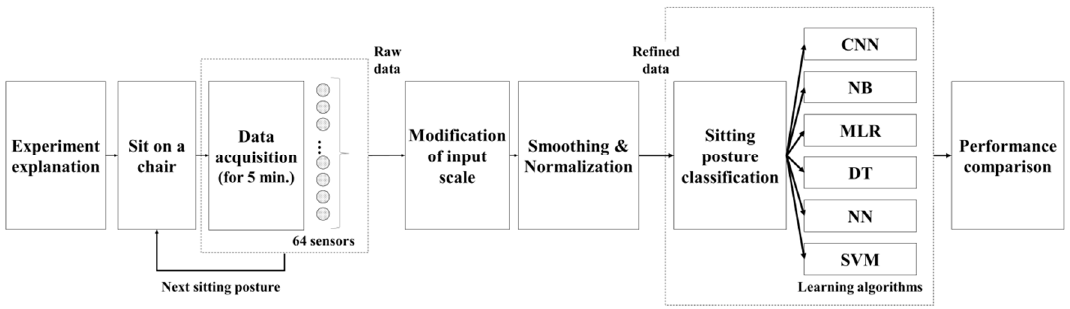
Figure 5. Block diagram of proposed analysis.